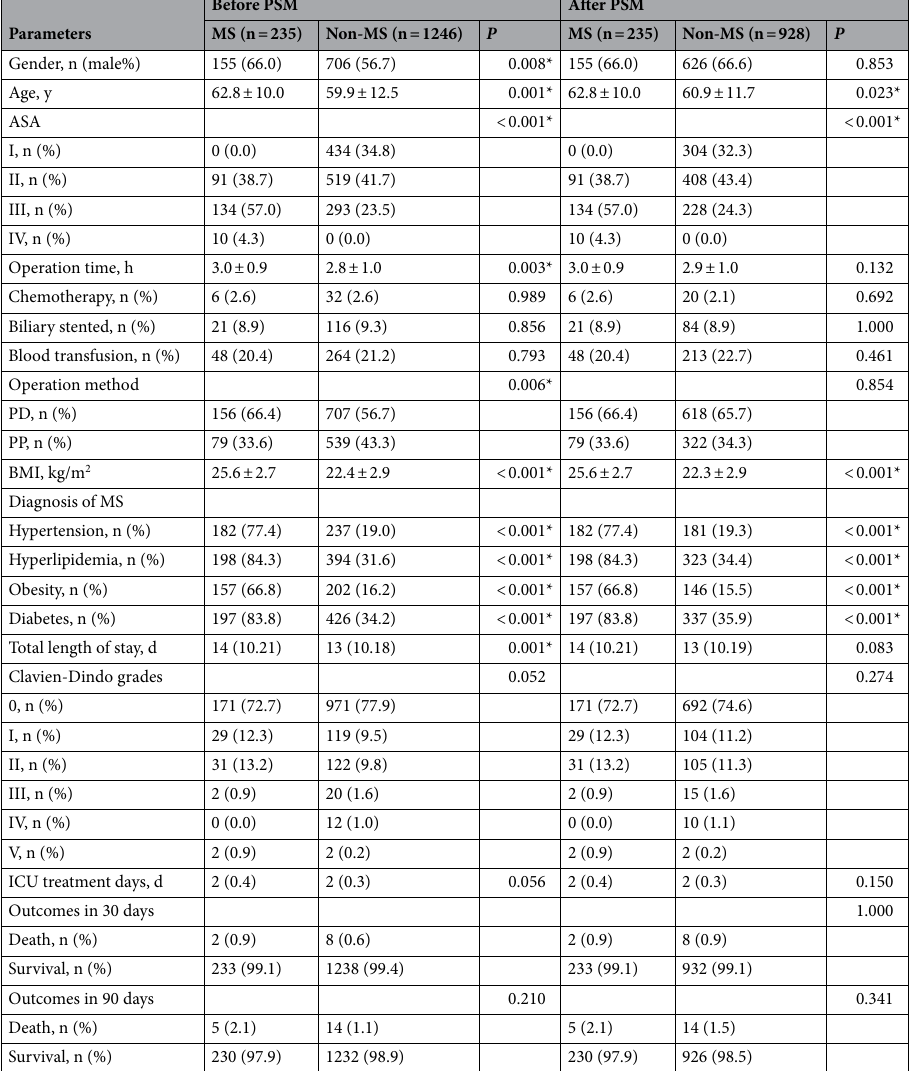
Table 1. Descriptive data and outcomes of patients. * P value was less than 0.05, with statistical significance. MS Metabolic syndrome, PSM Propensity score matching, Non-MS Non-metabolic syndrome, Chemotherapy Preoperative chemotherapy, Biliary stented Preoperative biliary stented, PD Pancreatoduodenectomy, PP Partial pancreatectomy.